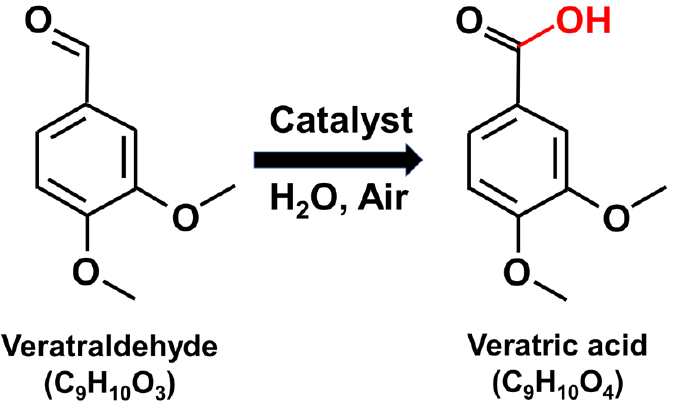
Figure 1. Catalytic oxidation of veratraldehyde to veratric acid.